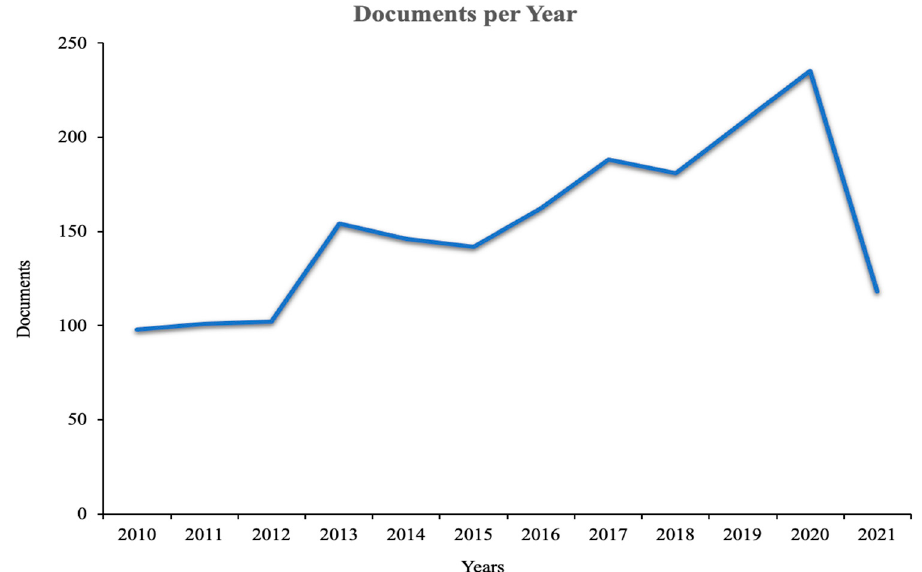
Figure 3. Number of publications for drought analysis per year.